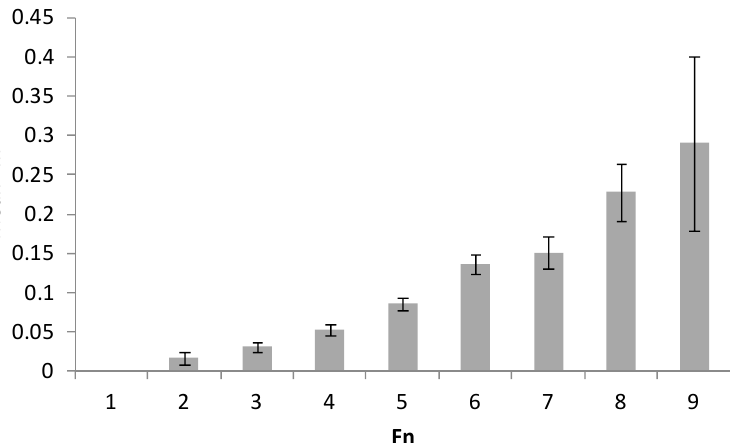
Figure 8. Mean error level per the number of information items, von Neumann neighborhood ( F N ).